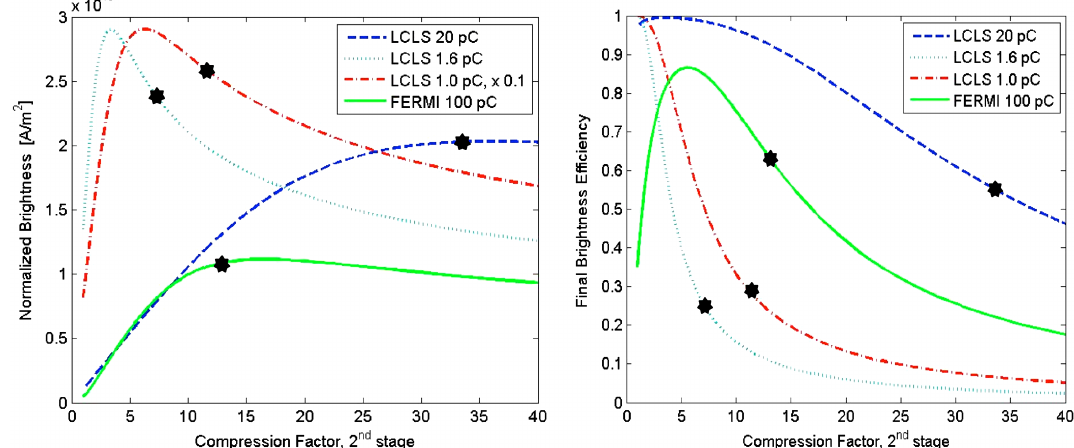
FIG. 5. Final normalized brightness (left) and brightness efficiency (right) as a function of the compression factor in the second compressor, for the scenarios depicted in Table II. The star identifies the compression factor that is needed to reach 1.5 kA final peak